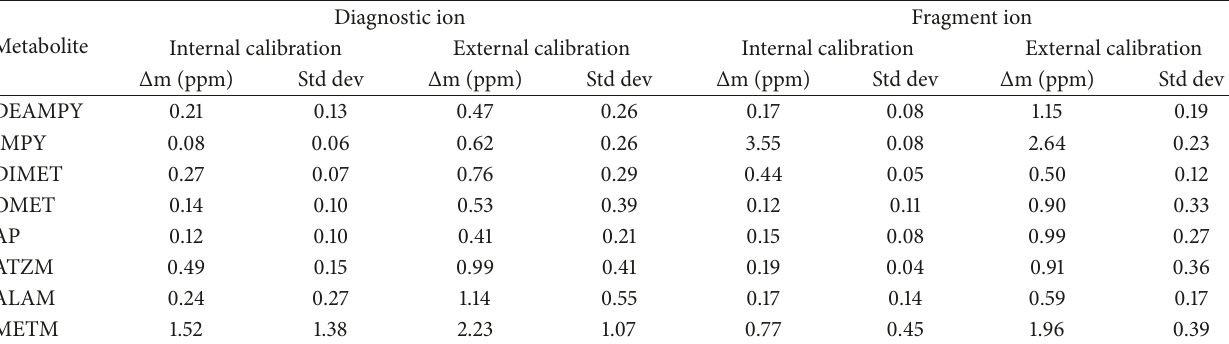
Table 5: Average mass accuracies ( (cid:2) m) (ppm) and standard deviations (Std dev) using internal and external calibration for diagnostic and fragment ions in ESI positive mode (n=5).